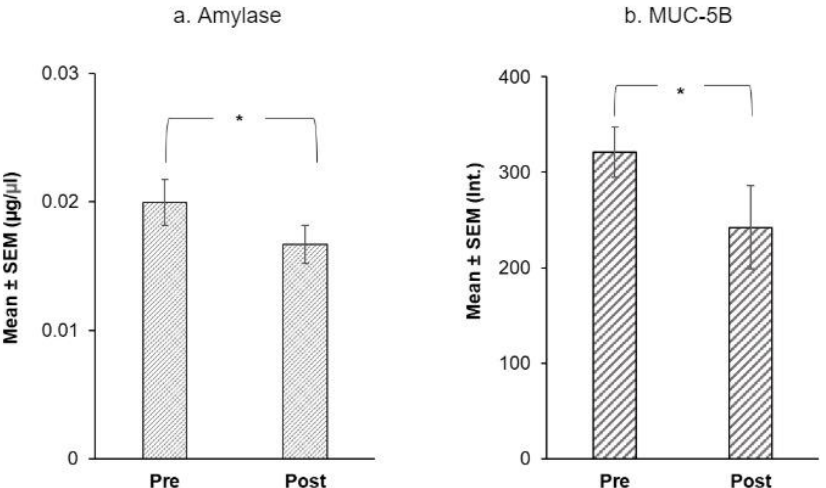
Figure 5. Immunoblot analysis of ( a ) mean α -amylase ± SEM ( µ g/ µ L) and ( b ) MUC-5B ± SEM (mean intensity of chemiluminescent signal) before and after the CPE oral rinse intervention. * shows significant effect of treatment ( p < 0.05) based on Friedman’s ANOVAs ( n = 20).